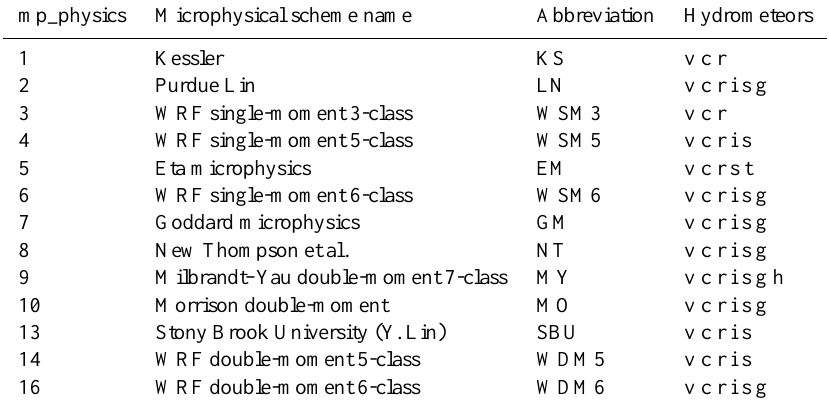
Table 1. The microphysical schemes available in WRF v3.3.1. mp_physics is the corresponding option to be used in the configuration file to activate them. The abbreviations are used throughout the whole document to refer to the schemes. The hydrometeors computed by the schemes are v, water vapour; c, cloud water; r, rain; i, cloud ice; s, snow; g, graupel; t, total condensate; and h, hail. The WSM3 scheme also computes cloud ice and snow but includes them in cloud water and rain,